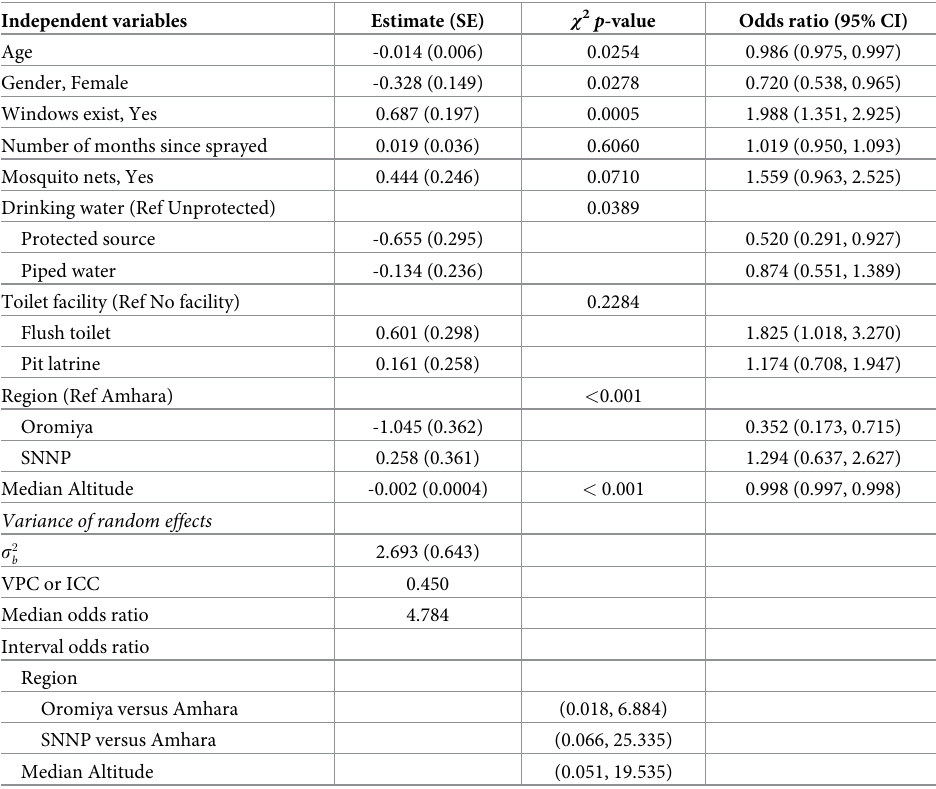
Table 3. Estimated odds ratios (95% confidence intervals) for model M 2